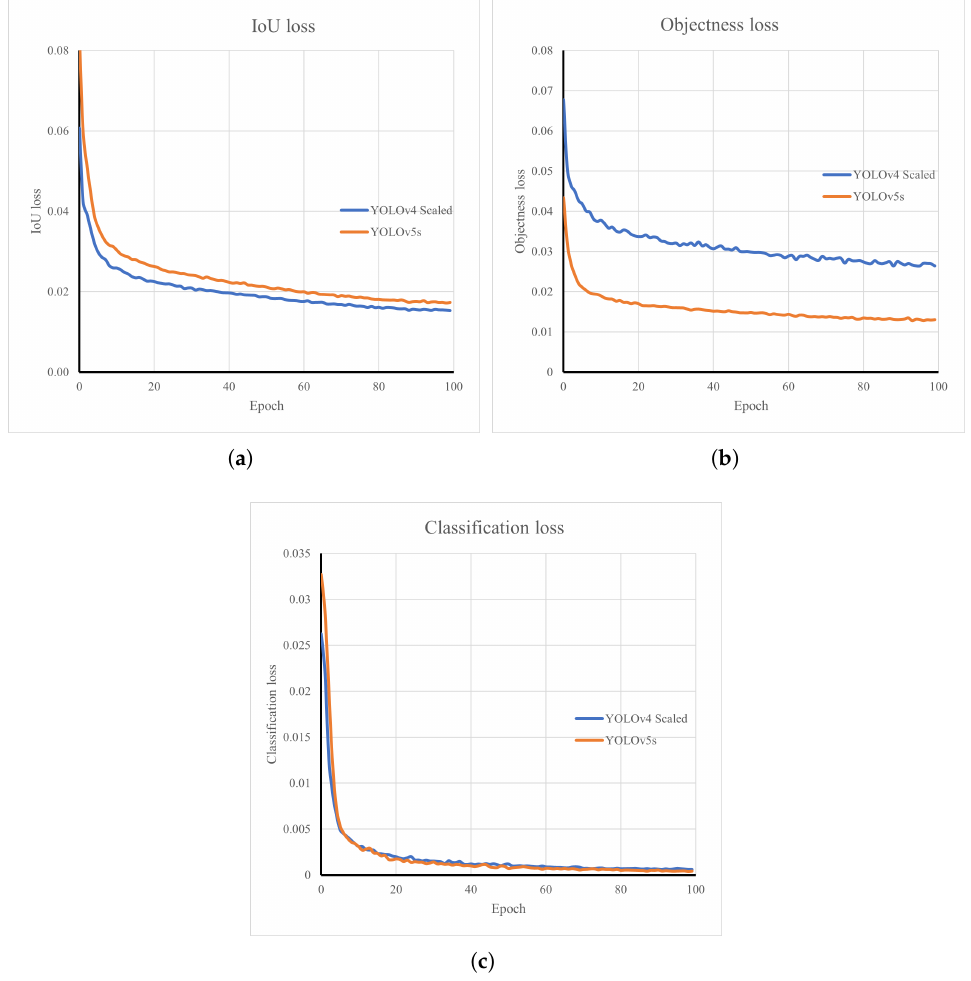
Figure 7. IoU ( a ), objectness ( b ), and classification ( c ) loss of YOLOv4-Scaled and YOLOv5s